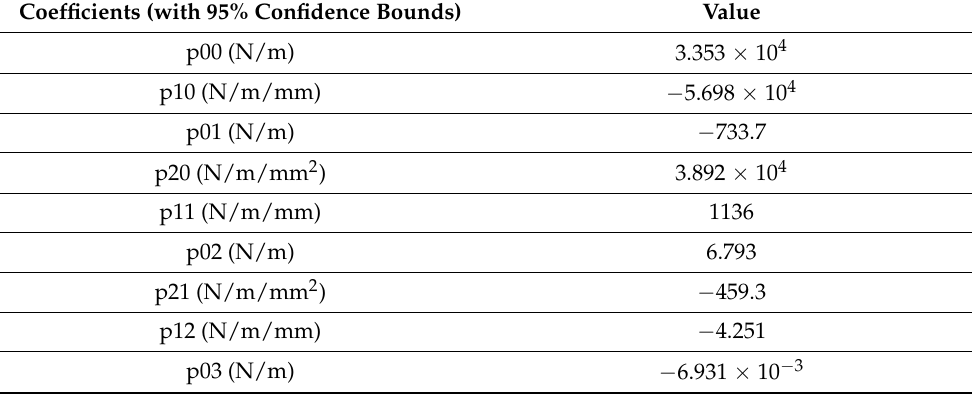
Table 7. Regression coefficients for Multiple Linear Regression (MLR) correlation between process parameters and